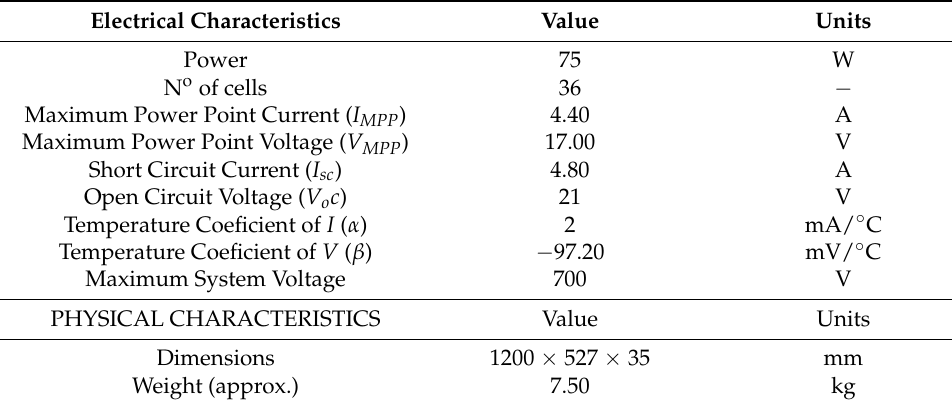
Table 1. Characteristics of Atersa A-75M